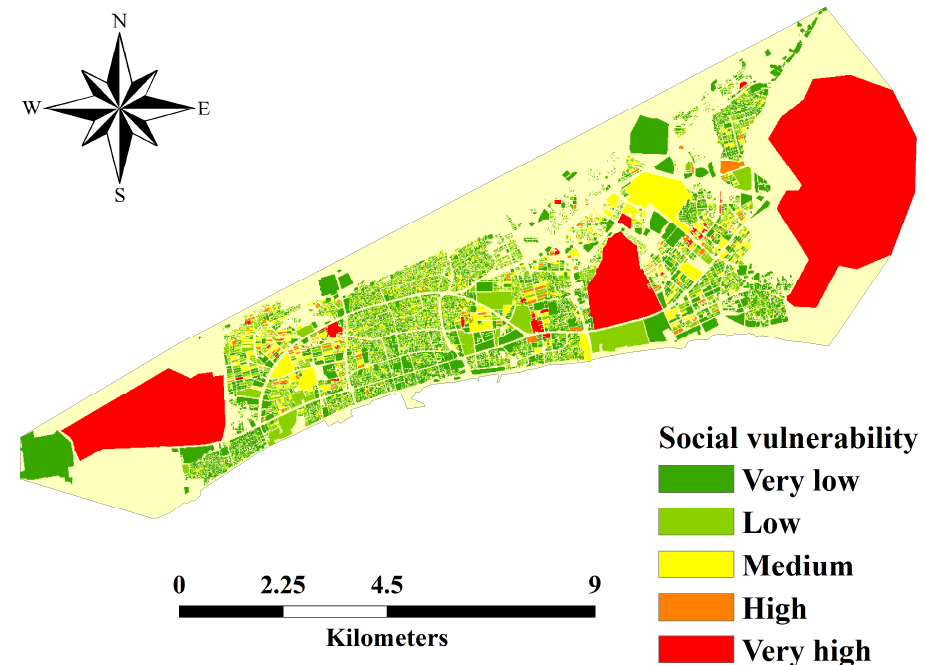
Figure 4. The spatial pattern of social vulnerability in Bandar Abbas City.